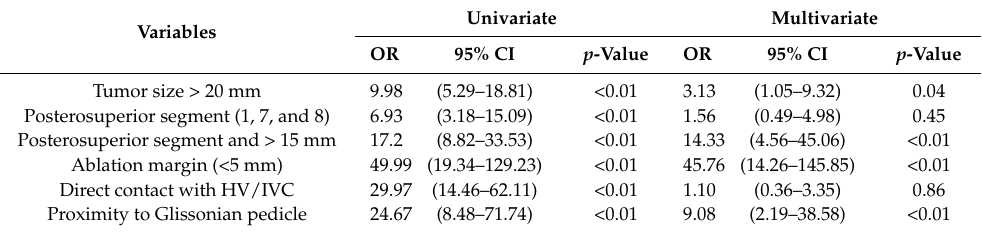
Table 4. Predictors for local recurrence after MWA in tumorous lesions ablated with MWA.